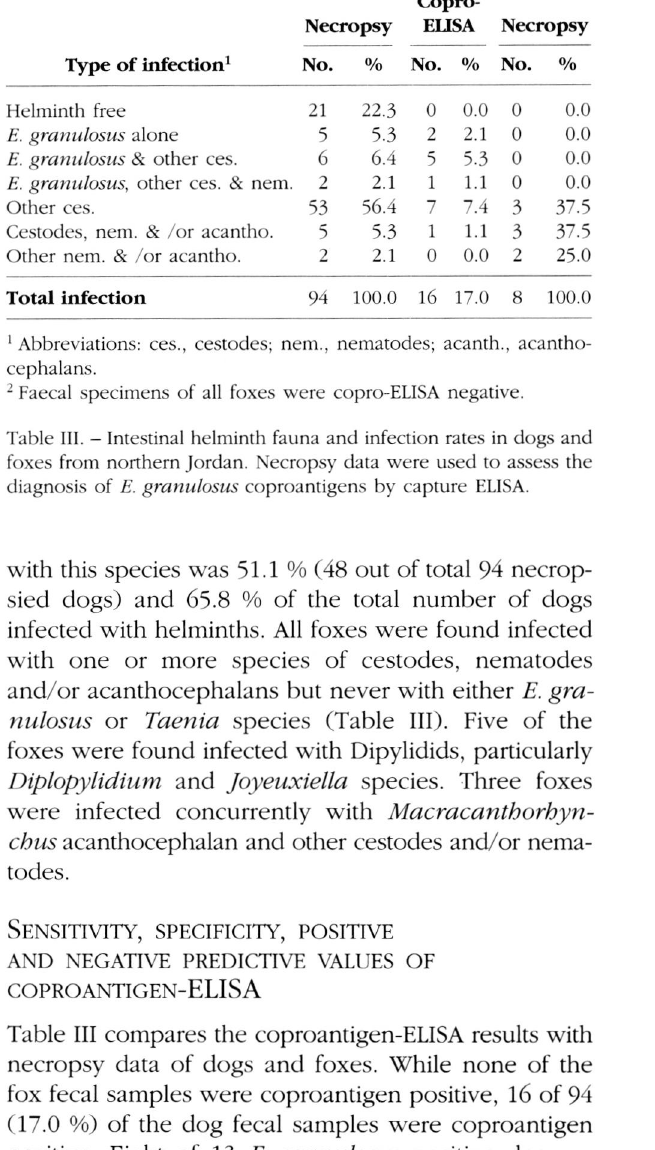
Table 1. - Rates of dog infection with E. granulosus either alone (single infection) or concurrent infections with other helminths in 94 dogs from northern Jordan.